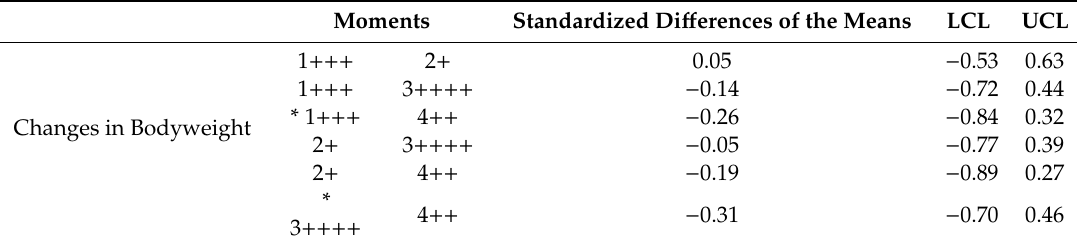
Table 5. Standardized di ff erences of the variable analyzed bodyweight at the di ff erent moments: The Madrid Junior Judo Championship (MJJC) (moment 1), Madrid Judo Clubs League (MJCL) (moment 2), Spanish Junior Judo Championship (SJJC) (moment 3), and Spanish National Judo Clubs League (SNJCL) (moment 4). Moments Standardized Di ff erences of the Means